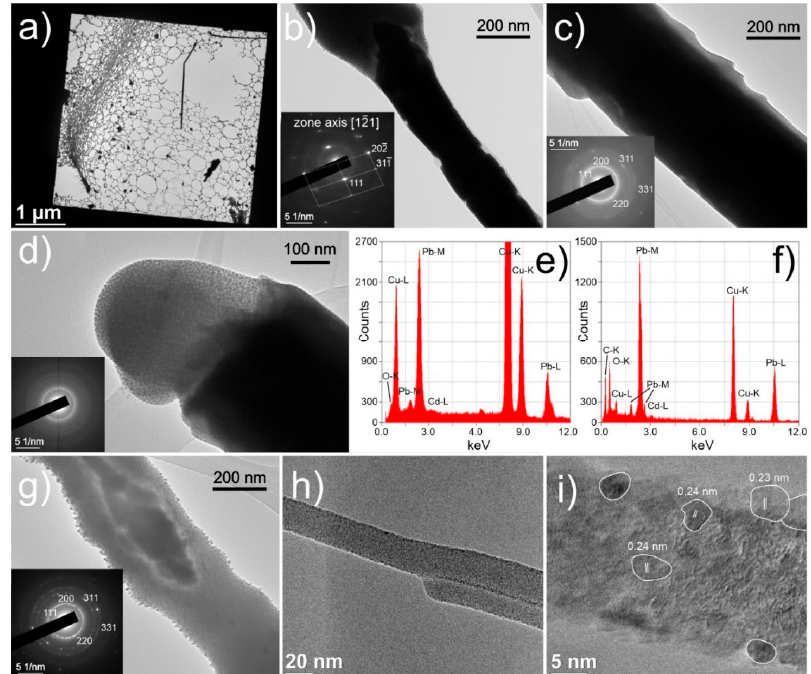
Figure 6. ( a – d ) and ( g – i ) Transmission electron microscopy images of sections of Pb whiskers. The inserts in images ( b – d ) represent the individual selective area electron diffraction patterns obtained from the center part of the corresponding images. Energy dispersive X-ray spectrograms of ( e ) central, bulk part of Pb whisker and ( f ) side region of Pb whisker with oxide layer. The Cu signal originates from the Cu gratings of the holding grid. In ( i ) the resolving power is limited by the thermal drifting of the sample, resulting in isolated focused regions/crystals for which the interatomic distances are determined. The marked interatomic distances correspond to the {200} of the Fm-3m Pb.